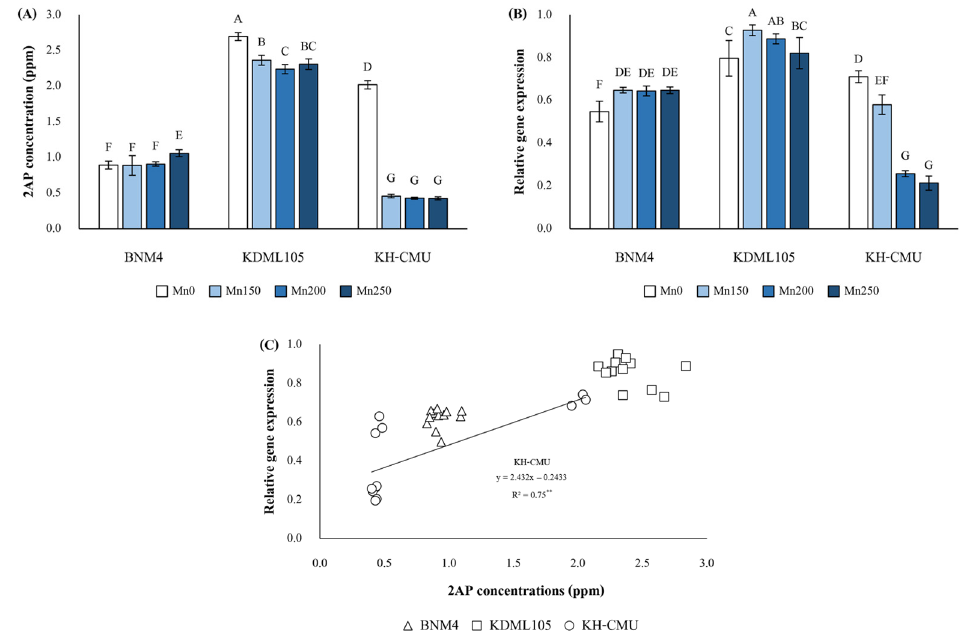
Figure 2. Effects of different manganese concentrations on the grain 2AP concentration ( A ), relative gene expression ( B ) and correlation between the 2AP concentration and relative gene expression ( C ) of different Thai fragrant rice varieties. Each column represents the mean of three data points ± standard errors ( n = 3). Means sharing a common letter do not differ significantly at p < 0.05. ** Significantly different at p < 0.01.